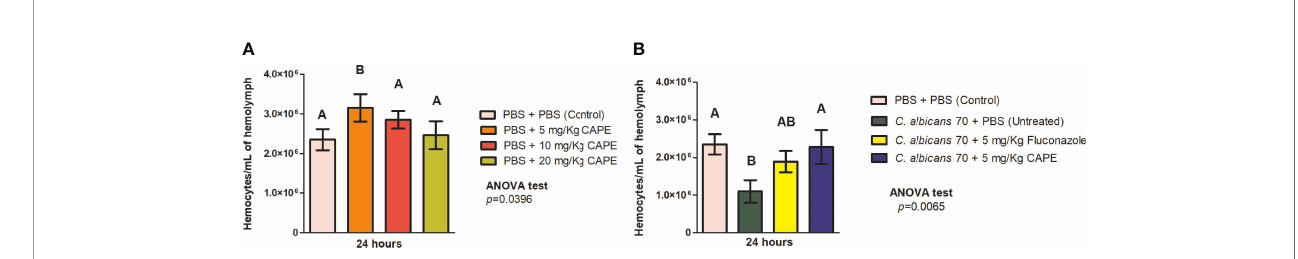
FIGURE 5 | CAPE modulates the immune system of G. mellonella . (A) G. mellonella larvae were injected with serial concentrations of CAPE increased the hemocyte number compared to a PBS control (PBS + PBS). (B) The group of CA70 + CAPE (5 mg/Kg) increased signi fi cantly the hemocyte number compared to CA70 + PBS (untreated). CA70 + PBS group showed a reduction of hemocyte quantity in relation to the PBS control group, but when the larvae were treated with CAPE, the hemocyte quantity was very similar to the values found in the PBS control group. The number of hemocytes slightly increased in the group of CA70 + fl uconazole (5 mg/Kg) but did not show differences in relation to the CA70 + PBS group. Different letters A and B represent statistically signi fi cant differences among the groups. ANOVA and Tukey Tests ( p < 0.05 was considered signi